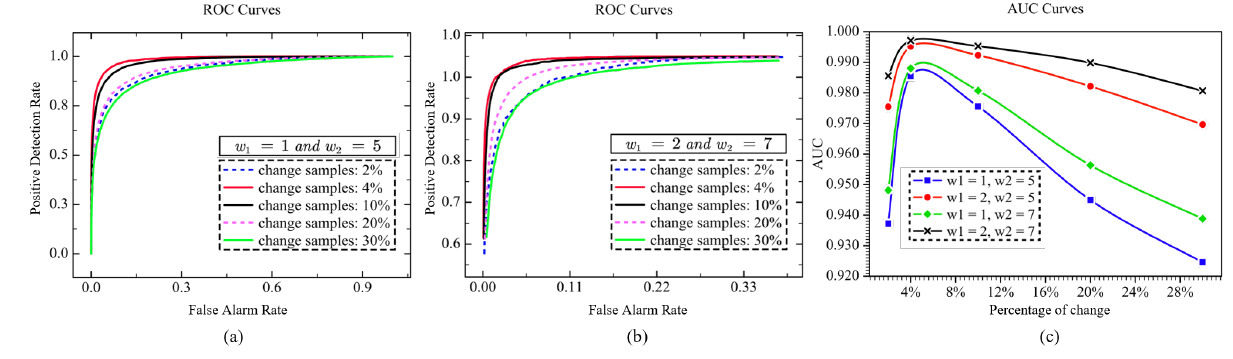
Figure 14. The evaluation curves on five simulated bi-temporal images. ( a ) ROC curves under the parameters { w 1 = 1, w 2 = 5 } . ( b ) ROC curves under the parameters { w 1 = 2, w 2 = 7 } . ( c ) AUC curves under four sets of parameters.